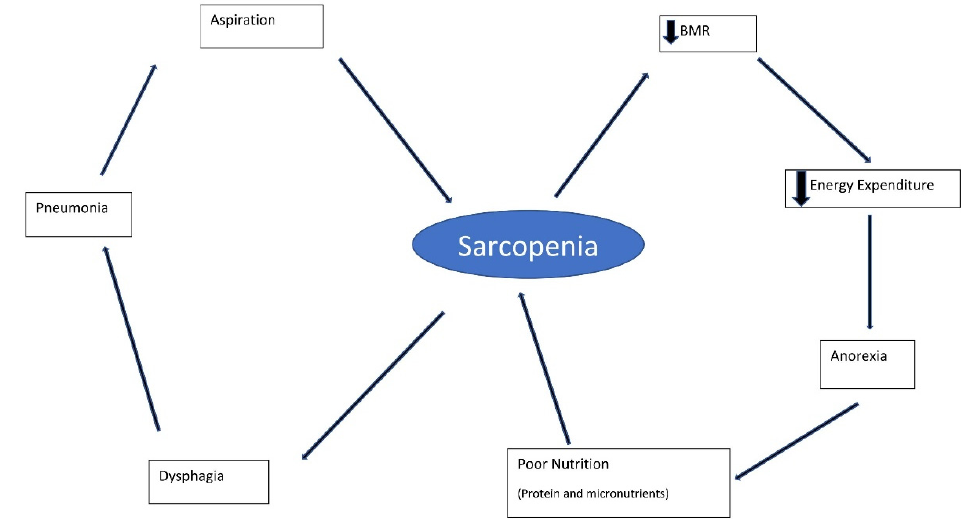
Figure 2. Frailty–pneumonia cycle. BMR: Basal metabolic rate.